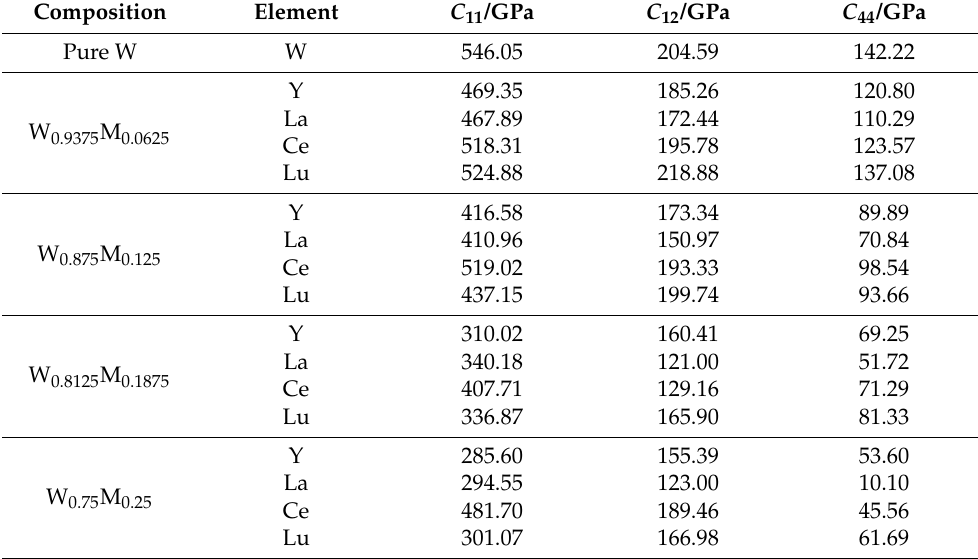
Table 4. Elastic constants of bcc W 1 − x M x